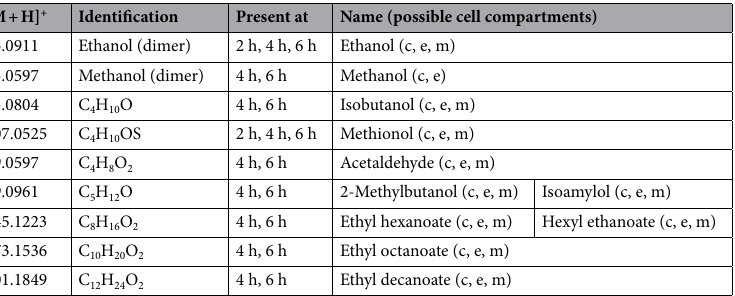
Table 1. Measured volatile metabolites that are also listed in the Yeast8 genome-scale model. Abbreviations for cell compartments: c (cytoplasm), e (extracellular), m (mitochondrion), n